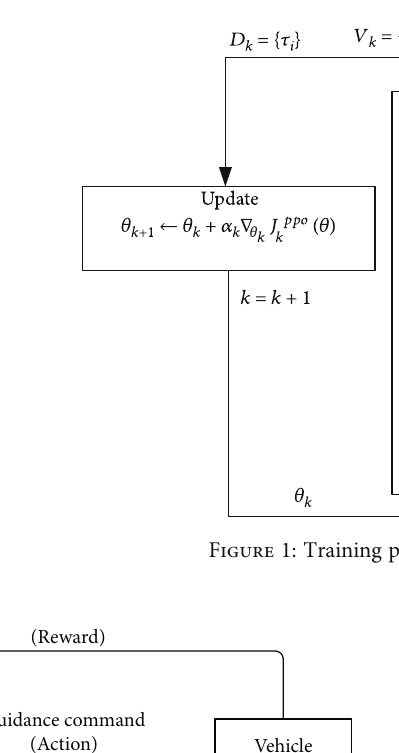
Vehicle (Environment)RL-guidance